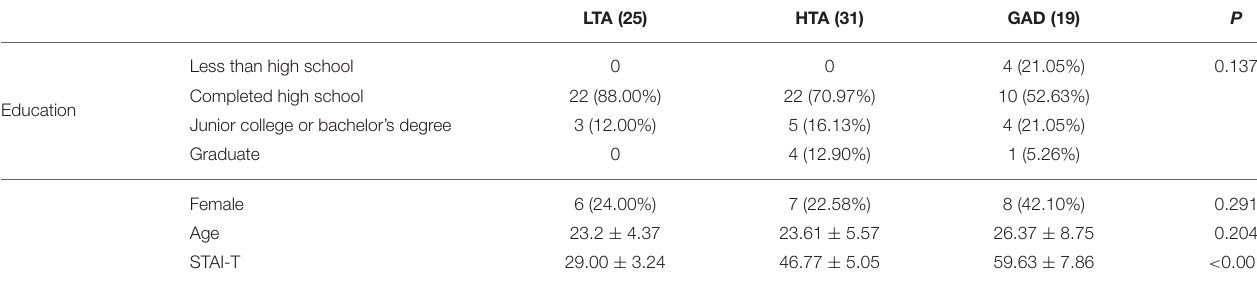
TABLE 1 | Demographic and STAI-T data for participants (mean ± SD).